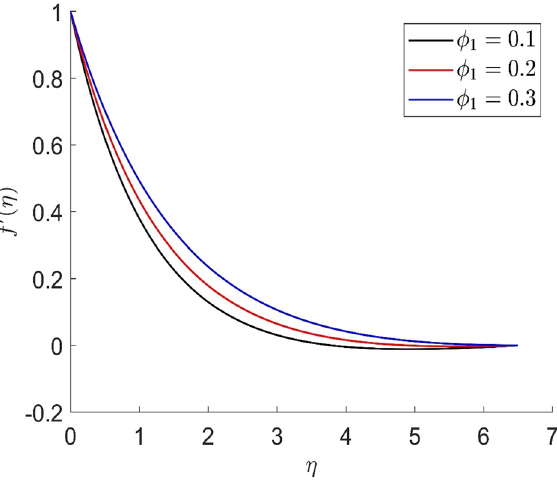
Figure 15. Representation of radial velocity f ′ (η) for the different values of φ 1 with R = 3, n = 3, v = 0.8, m = 3.5, Pr = 0.9, φ = 0.1, φ 2 = 0.7, β 3 = 0.6, β = 0.3, β 1 = 0.5, β 2 = 0.8, u = 0.5, ξ = 2.5.